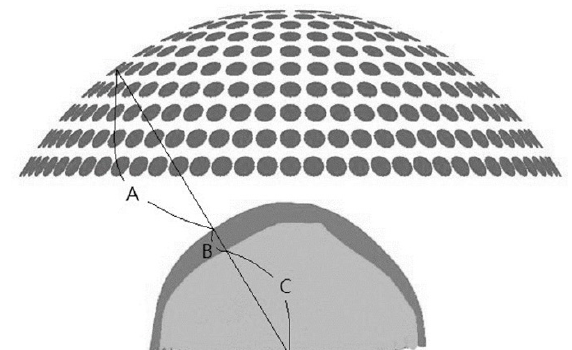
Figure 2. The hypothesized acoustic path of each element to the target brain tissue. The straight path was assumed to estimate the compensated phase of each element.